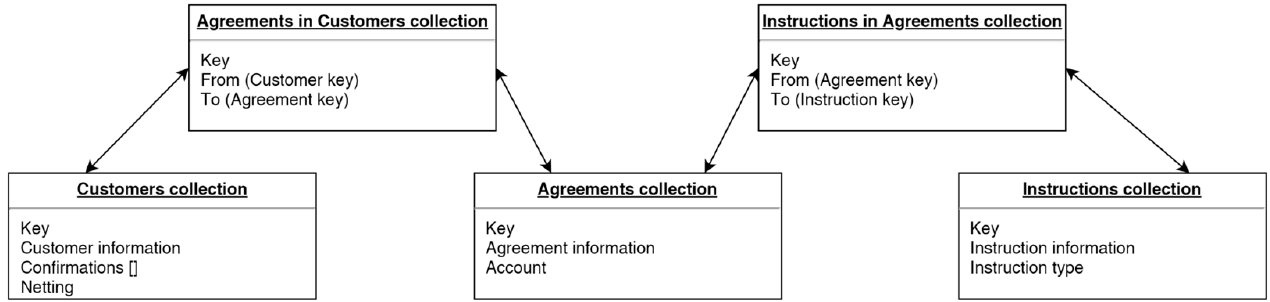
Figure 17. The physical data model.